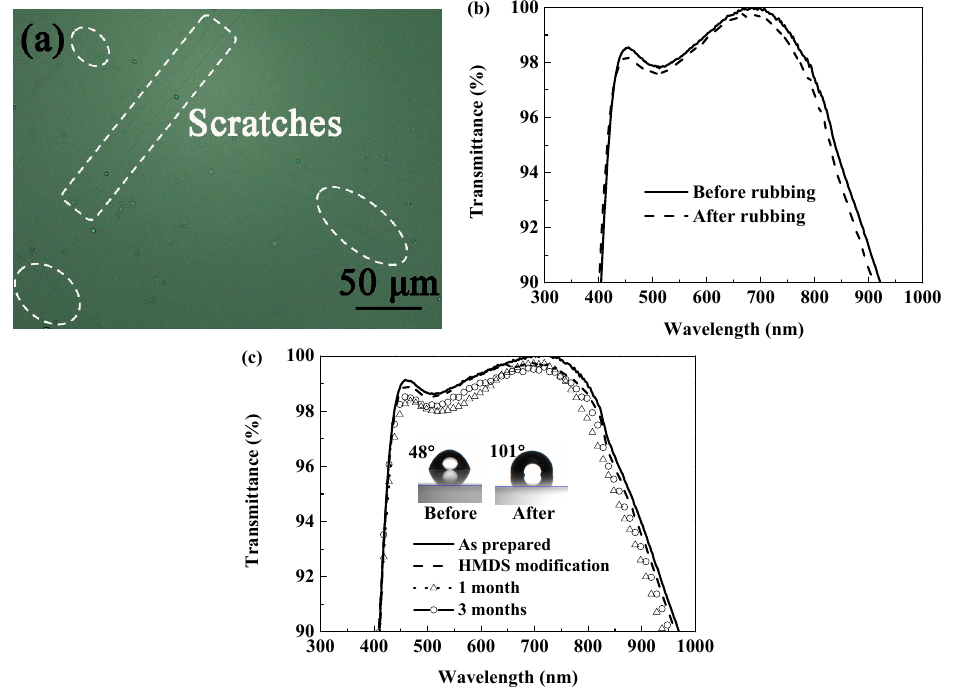
Figure 10. Durability tests of the triple-layer AR coatings. ( a ) Microscope photograph of coating surface after rubbing with a 3H pencil; ( b ) corresponding Transmittance spectra of the AR coating shown in ( a ); ( c ) change in transmittance of the AR coating before and after surface modification by HMDS. Insets are the corresponding water contact angle images. Transmittance spectra of the surface-modified coating placed in the normal air environment for one month and three months are also shown.